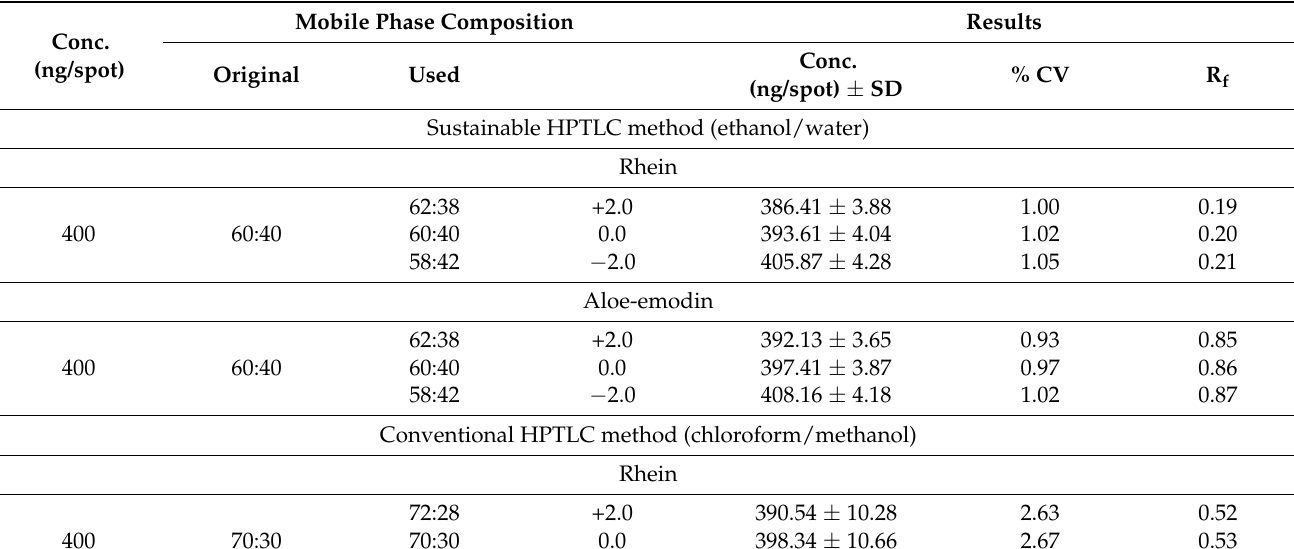
Table 5. Robustness data of rhein and aloe-emodin for the sustainable and conventional analytical assays (mean ± SD; n =